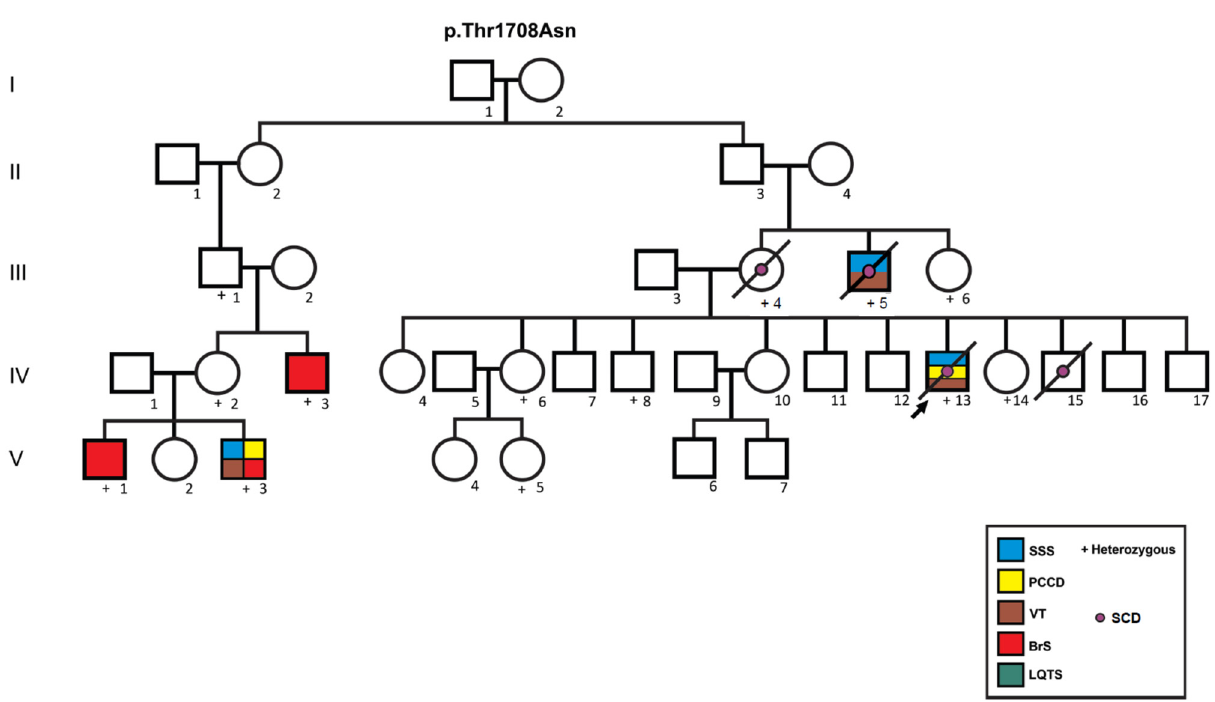
Figure 3. Pedigree of the family bearing the p.Thr1708Asn mutation. Circles indicate females, squares, males. Symbols with diagonal lines represent deceased individuals. Open symbols represent asymptomatic individuals, filled symbols are affected by arrhythmogenic syndromes according to the color code. Case 6 (V-3) and case 7 (IV-13) were initially thought to be unrelated, but after thorough interrogation were found to be first cousins once removed. Individual III-4 suffered sudden cardiac death at age 39 years, III-5 at age 56 years; and IV-15 at age 6 years. p.Thr1708Asn heterozygous individuals III-6, IV-6, IV-8, and V-5 had minor ECG manifestations, including prolonged PR and/or prolonged QTc intervals. SSS: sick sinus syndrome; PCCD: progressive cardiac conduction disease; VT: ventricular tachycardia; BrS: Brugada syndrome; LQTS: long QT syndrome; SCD: sudden cardiac death.